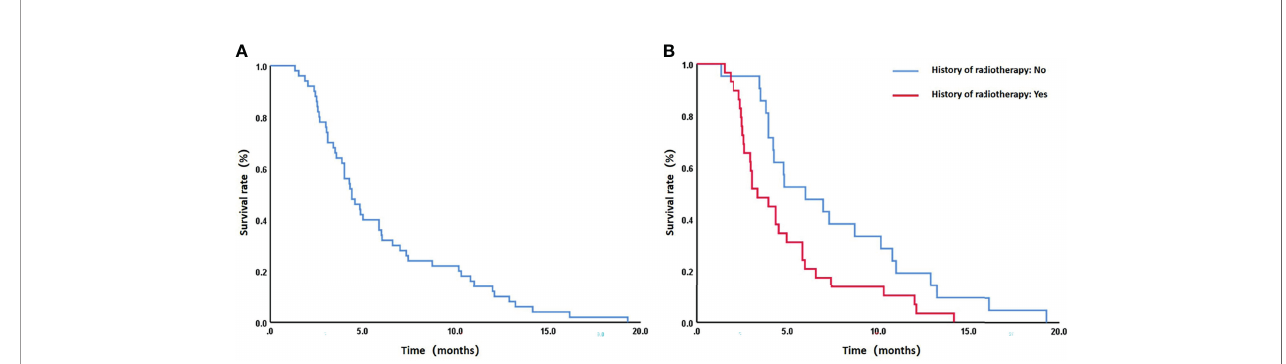
FIGURE 4 | (A) The overall 6-month, 12-month, and 18-month survival rates of all patients were 34%, 12%, and 2%, respectively. (B) For patients with and without a previous history of radiotherapy, the median survival periods were 3.4 months (95% CIL 2.1 – 4.7 months) and 6 months (95% CI: 2.8 – 9.3 months), respectively, and the 18-month survival rates were 0% and 4.8%, respectively. The difference of the latter was statistically signi fi cant (P = 0.021).